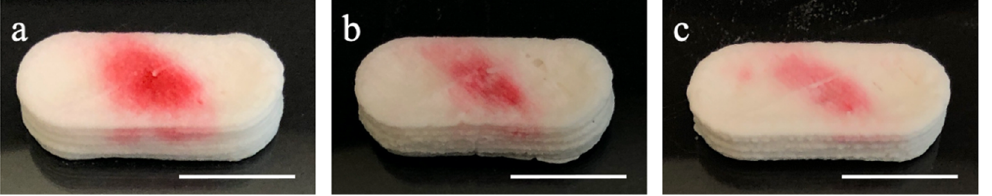
Figure 5. Capsule printed using: ( a ) CMC 8%; ( b ) CMC 10%; and ( c ) CMC 12% (lyophilized, scale bar in 1 cm).